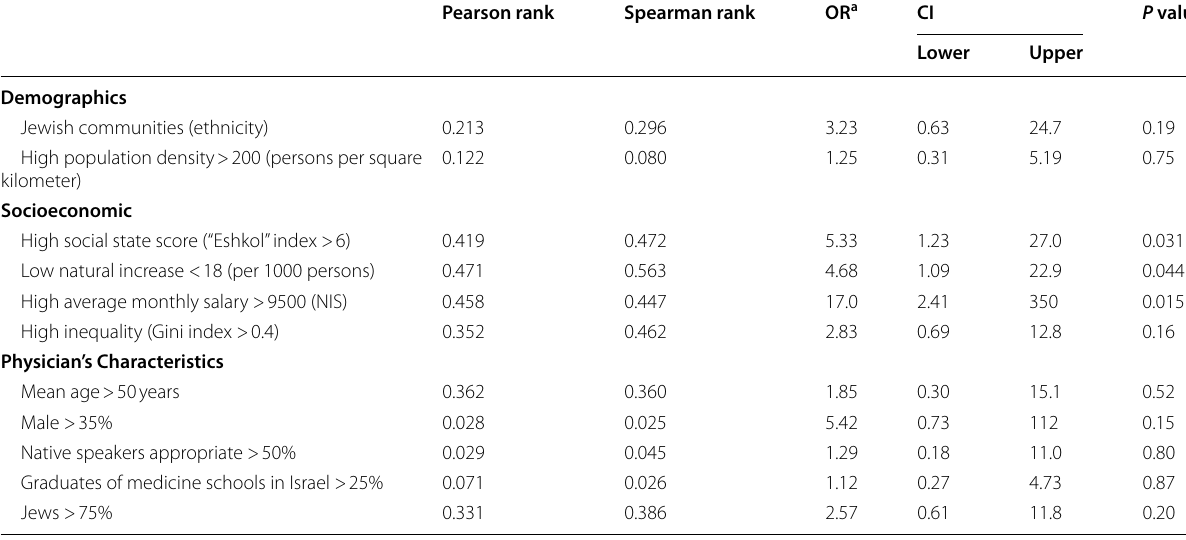
SMR standardized mortality ratio, OR odds ratio, CI confidence interval, NIS New Israeli Shekel a Uni-variable logistic regression model results; the outcome is high-rate SMR (cutoff, 1.0). It presents municipality-related characteristics associated with equal or higher than average